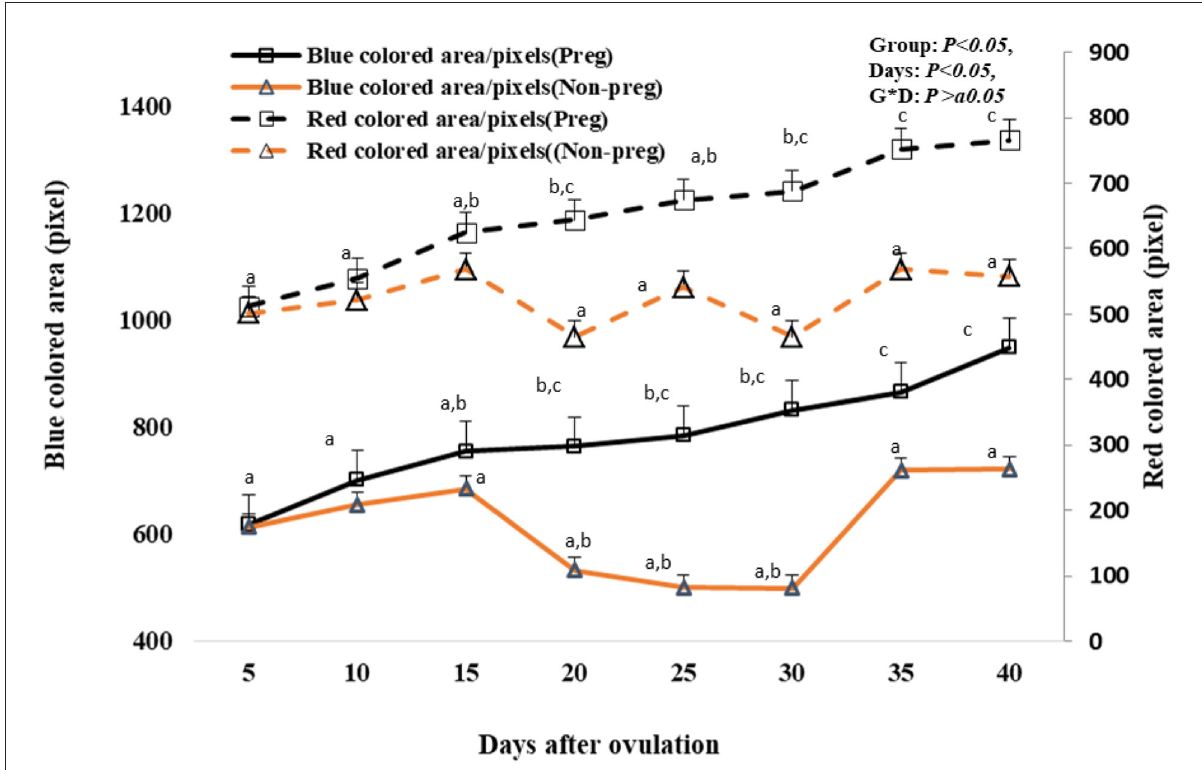
FIGURE10 Uterine blood flow area expressed by blue and red colored area/pixels presented in pregnant (Preg) and non-pregnant (Non-preg) buffalos from day 5 till day 40 after ovulation. Data are obtained as mean with standard error of mean. a,b Values are significantly different at P < 0.05 compared with day 5 in both groups, while c value is significantly different at P < 0.05 between two groups at the indicated same time